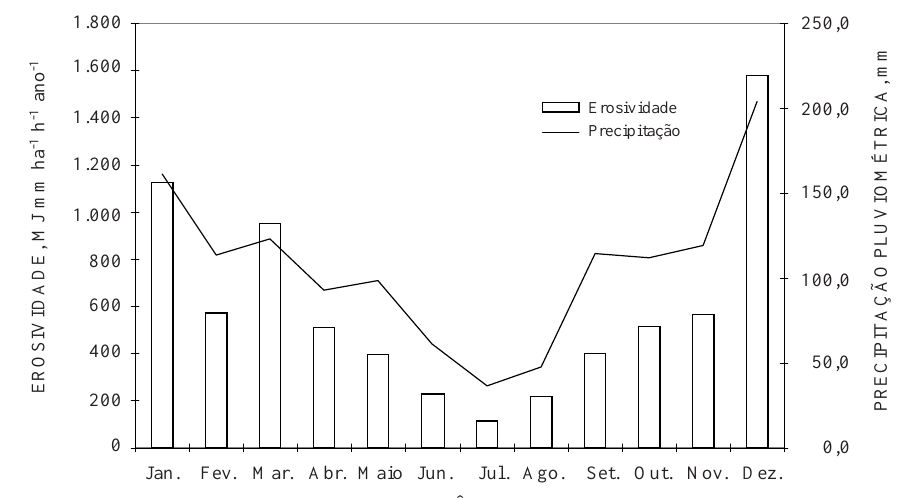
) e da precipitação pluviométrica médias anuais de Teodoro 30